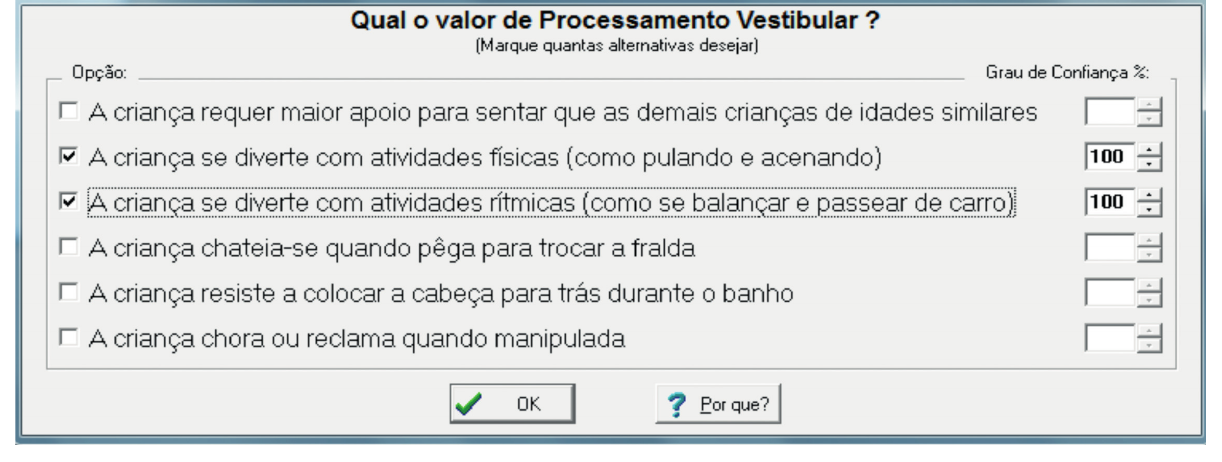
Figure 3 - Analysis of vestibular processing